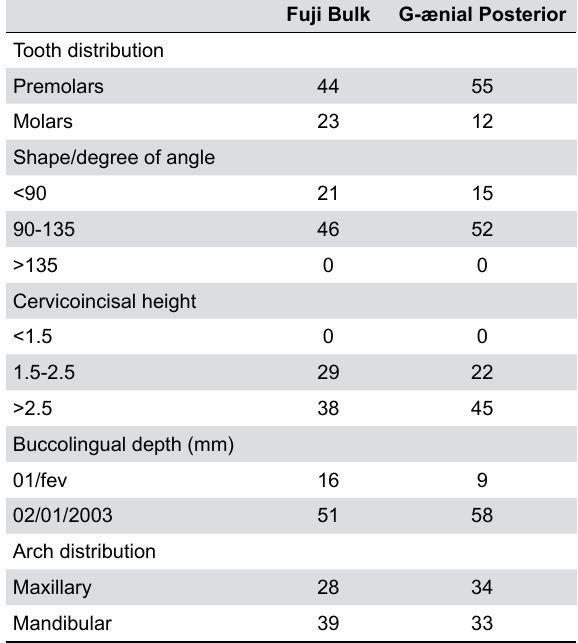
Figure 2- Application procedures of materials used in the study Table 2- Demographic Characteristics of Patients Table 3- Characteristics and Distribution of